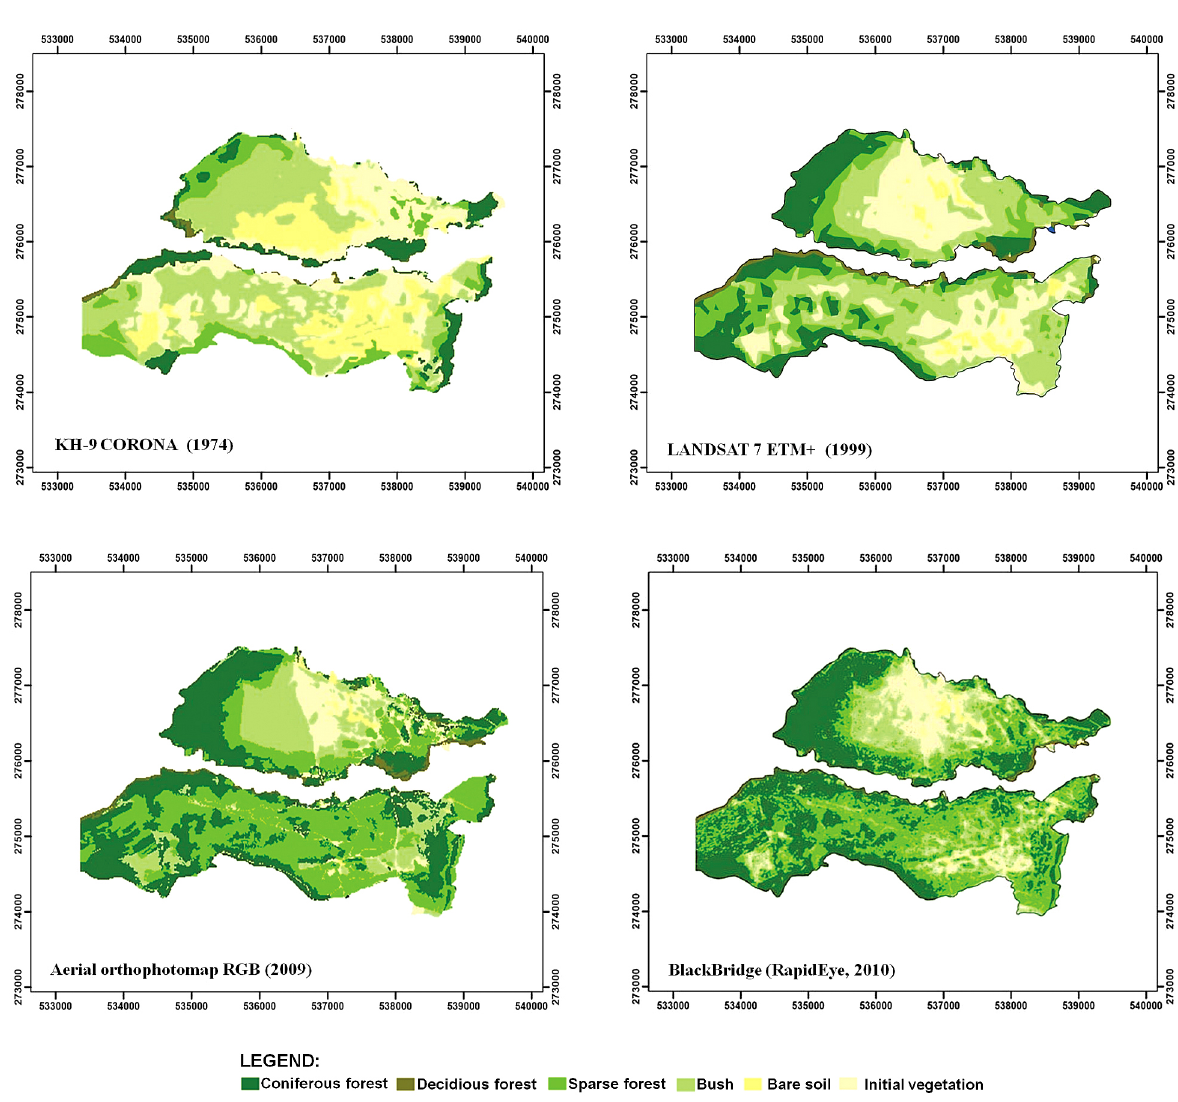
Fig. 3. LULC maps of the Błędów Desert. a) KH-9 CORONA (1974), b) LANDSAT 7 ETM+ (1999), c) aerial orthophoptomap (2009), d) BlackBridge (RapidEye, 2010).